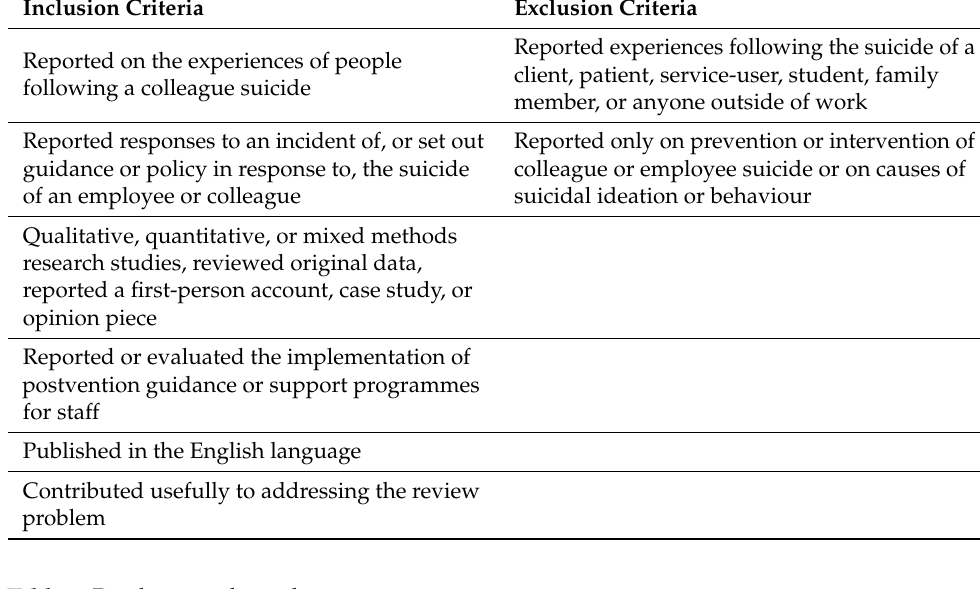
Table 2. Databases and search